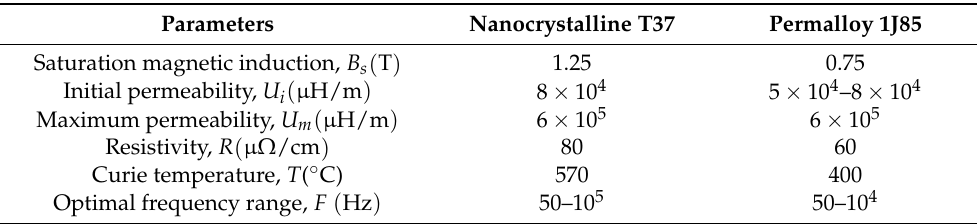
Table 2. Performance comparison of the two magnetic materials.